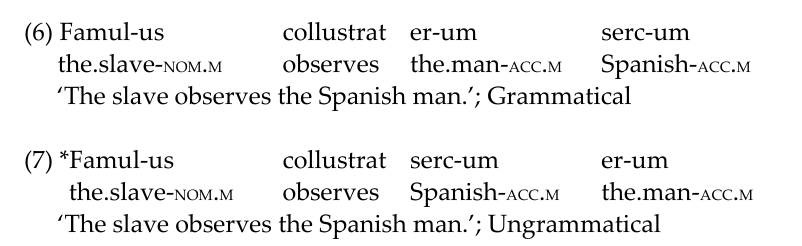
Table 2. The four experimental conditions for the Mini-Latin experiment (see glosses and transla- tions above).